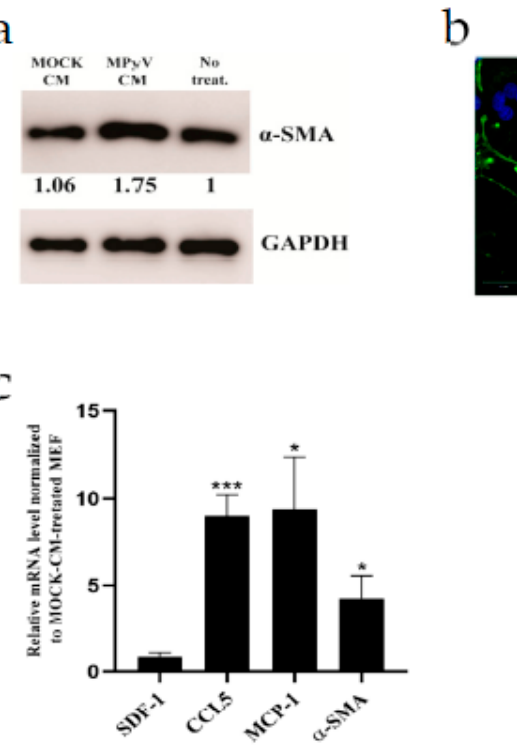
Figure 5. MPyV infection induces a cytokine environment that changes the fibroblast phenotype. ( a ) Analysis of alpha- smooth muscle actin ( α -SMA) expression in MEFs treated with MPyV-CM or MOCK-CM. The values shown below each band represent the relative quantity of α -SMA determined by densitometry normalized to non-treated MEF. GAPDH was used as the loading control. The α -SMA expression was analyzed 48 h post-treatment. ( b ) Confocal images of α -SMA distribution in MEFs treated with MPyV-CM or MOCK-CM. Laser settings and acquisition conditions were constant for both samples. The α -SMA distribution was analyzed 48 hours post-treatment. ( c ) The qPCR analysis of relative mRNA levels in MEFs treated with MPyV-CM. The qPCR analysis was performed 48 h post-treatment. Relative mRNA level was normalized to MOCK-CM-treated MEFs. Mouse Ppia was used as the endogenous control. The data are the mean ± SEM of four independent experiments. * p < 0.05; *** p < 0.001; two-tailed t -test.